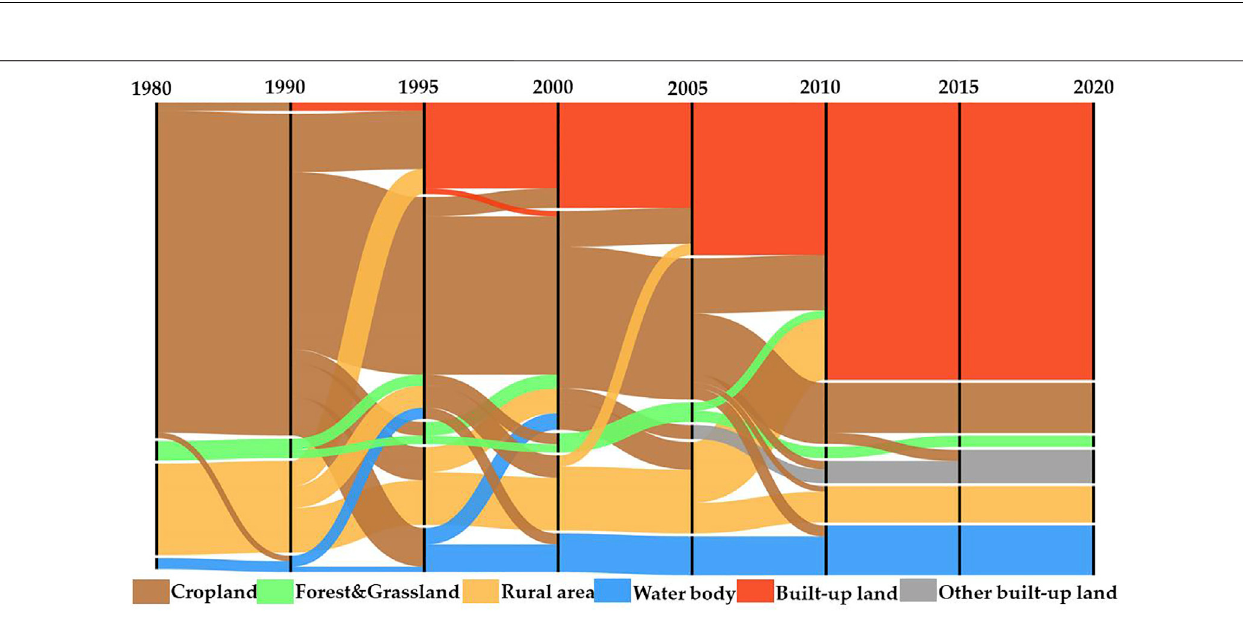
FIGURE 5 | Land-transfer paths within different time periods, 1980-2020.